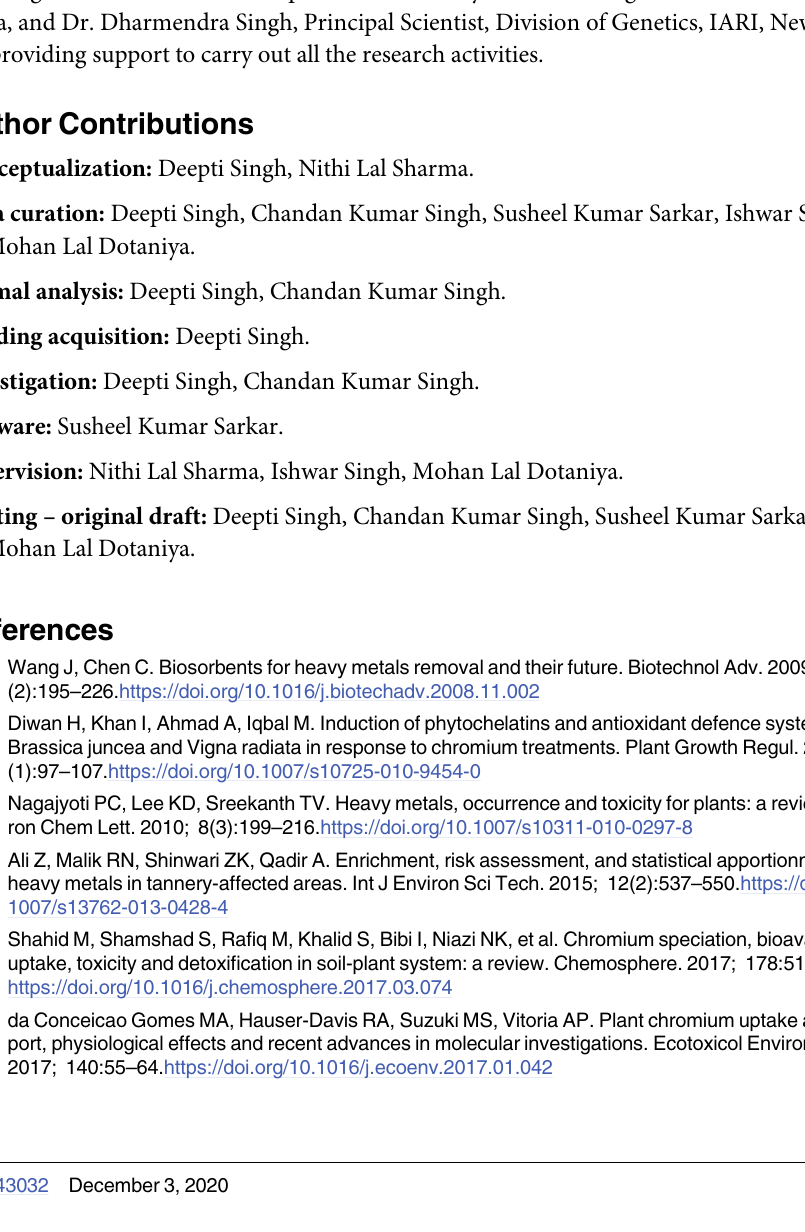
S1 Fig. Vigour index of two chickpea varieties under the different chromium (Cr) treat- ments. S2 Fig. Effects of the various chromium (Cr) on root and shoot nitrogen contents of two chickpea varieties grown in pots 95 days after treatment (DAT). (a) Pusa 2085 (b) Pusa Green 112. S3 Fig. Effects of various levels of chromium (Cr) on the protein contents of seeds of two chickpea varieties grown in pots (Pusa 2085 and Pusa Green 112) 140 days after treatment